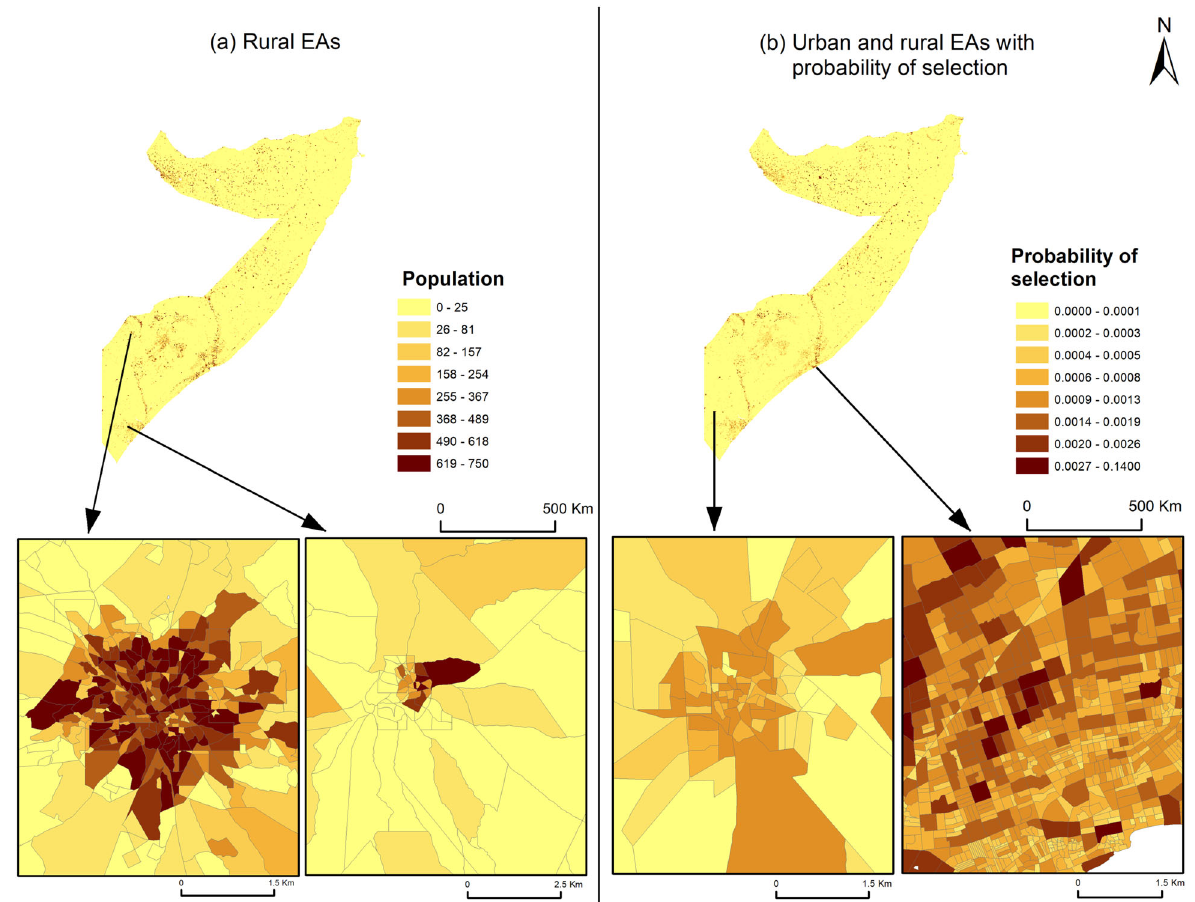
Fig. 4 The population size per regional strata. a Rural EAs in Somalia with the population size after the merging process, b Urban and rural EAs with their probability of selections proportional to the population size per regional strata. This product was generated after merging the splitting units until they match constraints designed to facilitate on the ground logistics of